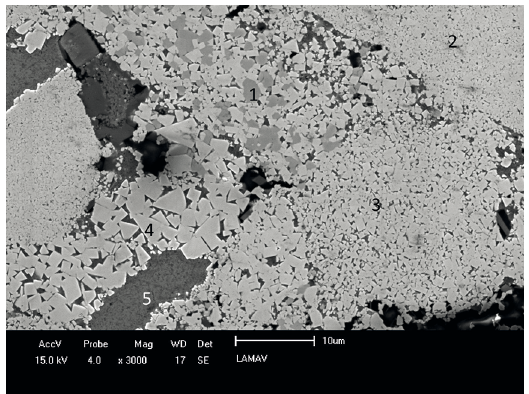
indicate. The region marked with 5 is likely a fragment of a cermet of a coating of hard metal